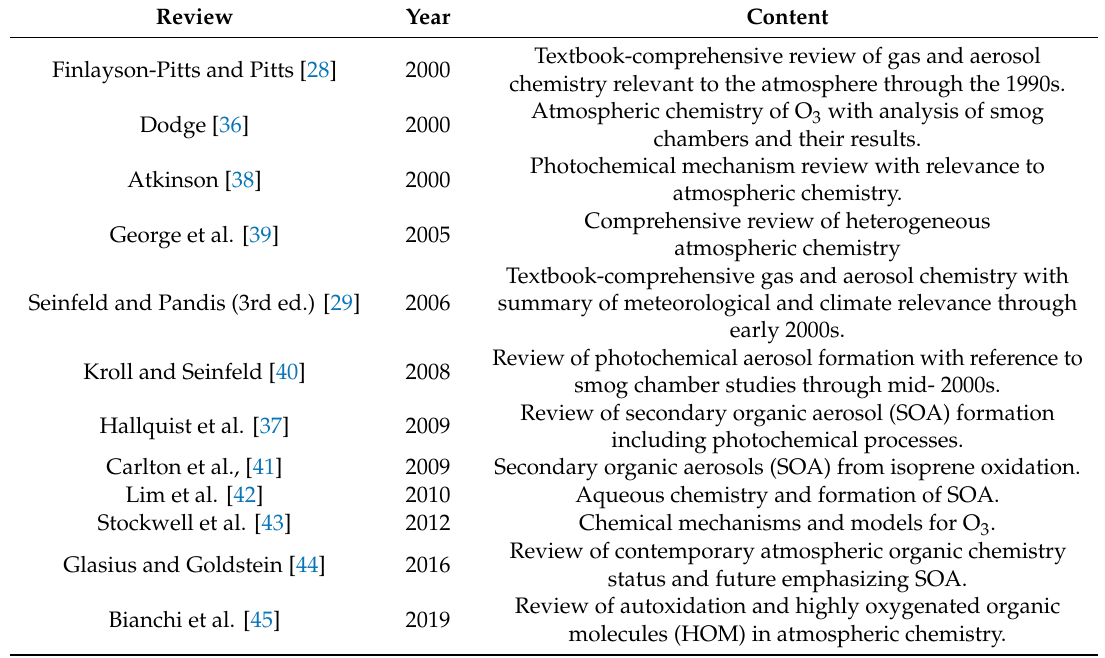
Table 1. Some reviews of studies relevant to atmospheric chemistry